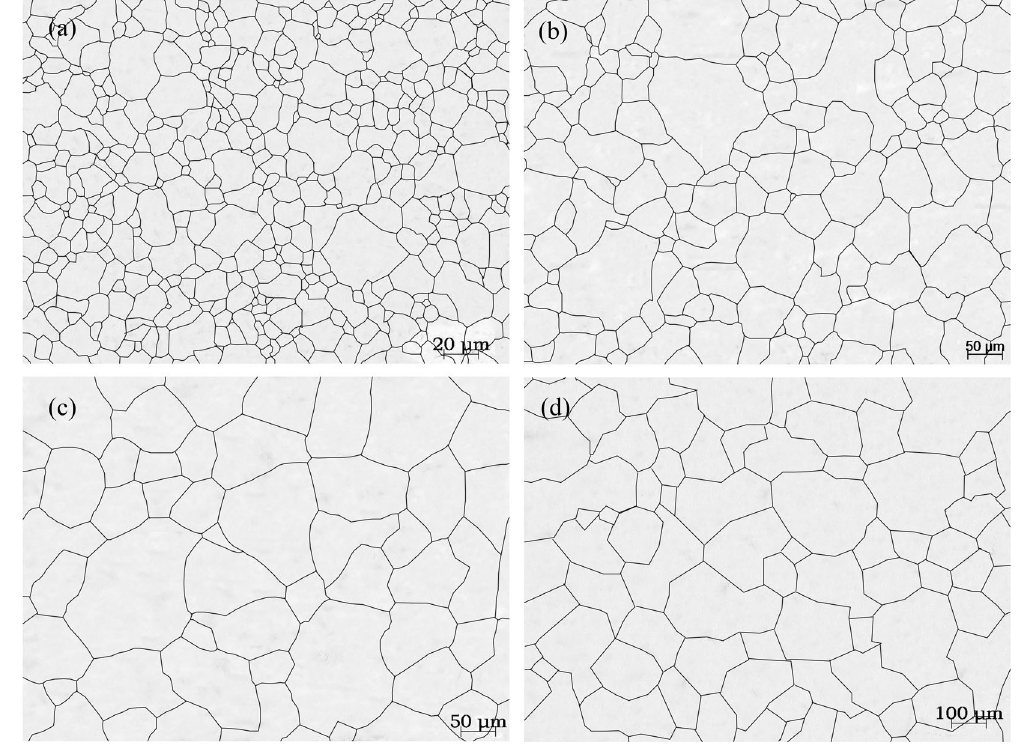
Figure 3. The effects of the heating temperature on the grain growth. ( a ) 800 °C; (b) 950 °C; ( c ) 1100 °C; and ( d ) 1250 °C.